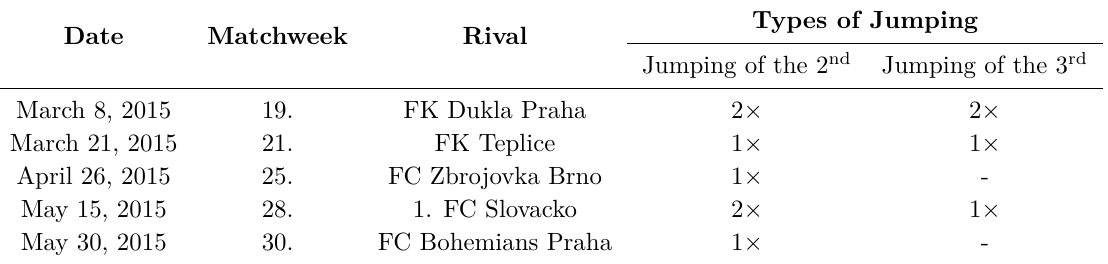
Types of Jumping Jumping of the 2 nd Jumping of the 3 rd